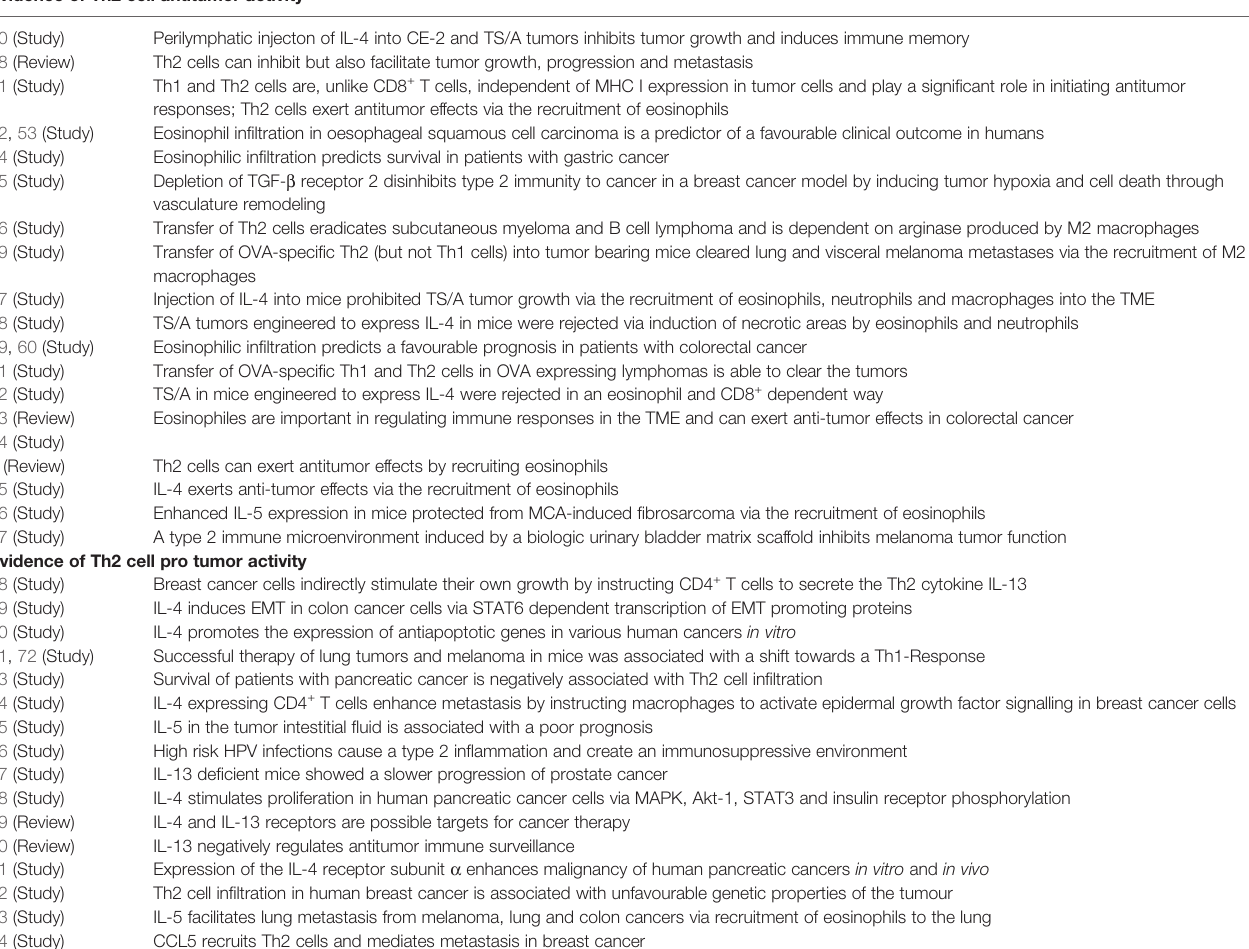
TABLE 2 | Studies on the role of Th2 cells on